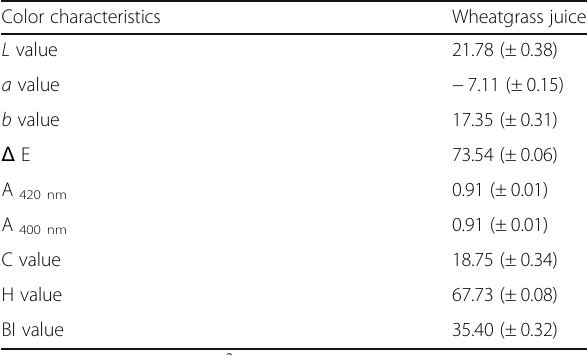
Table 2 Color characteristics and parameters of wheatgrass juice Color characteristics